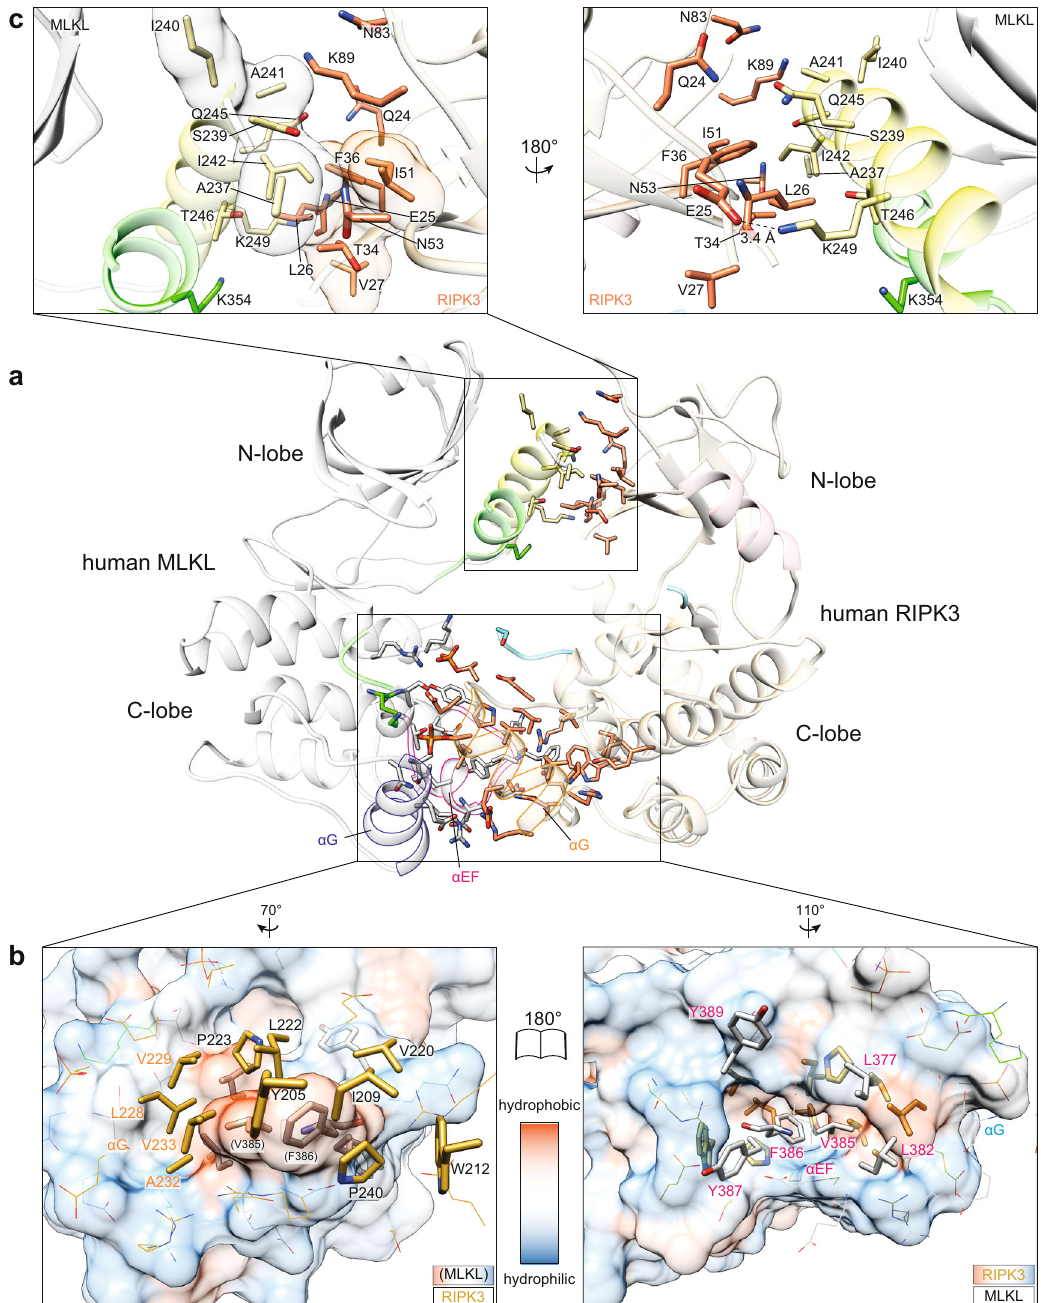
Fig. 4 The human RIPK3 and MLKL complex interface is dominated by C-lobe interactions. a The N-lobe interaction interface (top box) is less extensive than the C-lobe interface (bottom box). MLKL is colored gray with α C helix (yellow) and activation loop (green) highlighted. RIPK3 is colored magenta with α C helix (wheat) and activation loop (cyan) highlighted. Sidechains of interface residues (as predicted by PDBePISA) are shown as sticks. b Open book view of hydrophobic interacting residues within the C-lobe interface. RIPK3 sidechains are shown as orange sticks and MLKL sidechains as gray. The surfaces (left, MLKL; right, RIPK3) are colored according to hydrophobicity (red) and hydrophilicity (blue), as calculated by UCSF Chimera 76 . Other polar interface residues are shown as lines. c Zoomed and orthogonal views of the N-lobe interface of human RIPK3:MLKL shown in the box in panel a . Interface residues are shown as sticks; hydrophobic residues are shown as transparent surfaces; an electrostatic interaction is shown as a dashed Fig. 5c, d). In contrast, a subset of mutations within the C-lobe described activation loop mutant of MLKL, T357E/S358E 51 (Fig. 5b). Because F386A and T357E/S358E human MLKL interface in both RIPK3 and MLKL abrogated their capacity to mutants behaved equivalently in previous studies, where reconstitute the necroptosis pathway in RIPK3 − / − or MLKL − / − cells, respectively (Fig. 5b – f). While mutation of K331, R333, necroptotic signaling was completely abrogated by either S373, S378, Q388, N416, and R421 of MLKL did not compromise mutant 11,40,51 , we included only one mutant — T357E/S358E MLKL — in this study as a control. RIPK3 mutants that abolish their signaling capabilities, the V385W and S417D mutations either the hydrophobic pocket into which MLKL V385 and F386 prevented necroptosis from occurring, like the previously